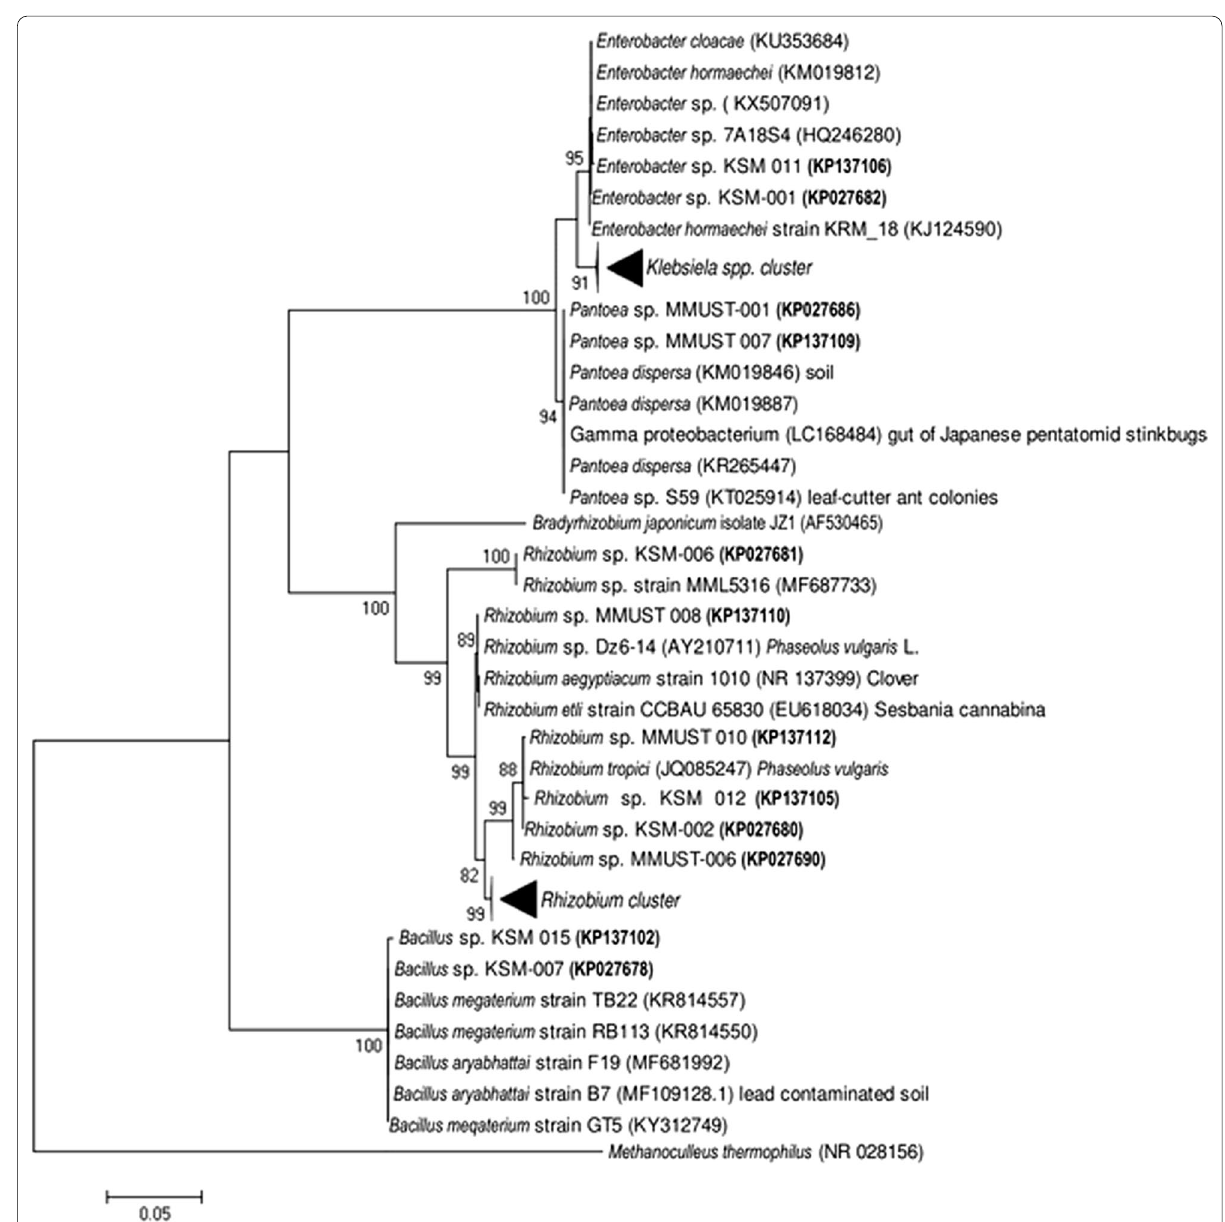
Fig. 1 Phylogenetic tree of the 16S rRNA gene isolates (in bold) and closely affiliated